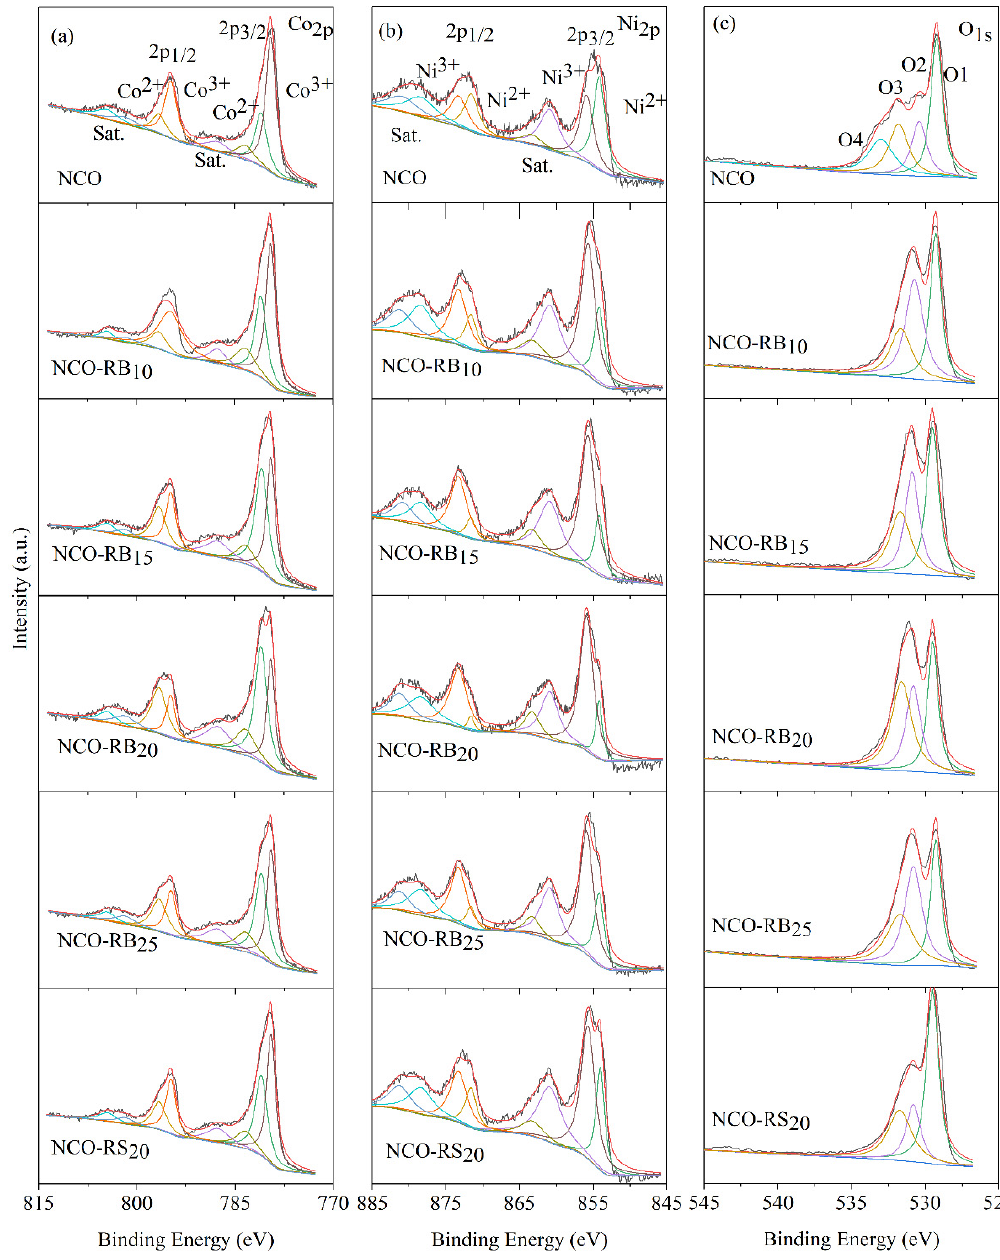
Figure 4. The X-ray photoelectron spectroscopy (XPS) profiles of NCO, NCO-RB 10 , NCO-RB 15 , NCO-